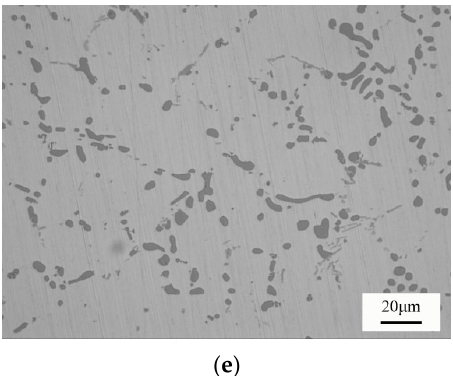
Figure 9. T6 magnification light optical micrographs of A357 alloy with different Ce content. ( a ) 0%, ( b ) 0.08%, ( c ) 0.16%, ( d ) 0.24%, and ( e ) 0.32%.